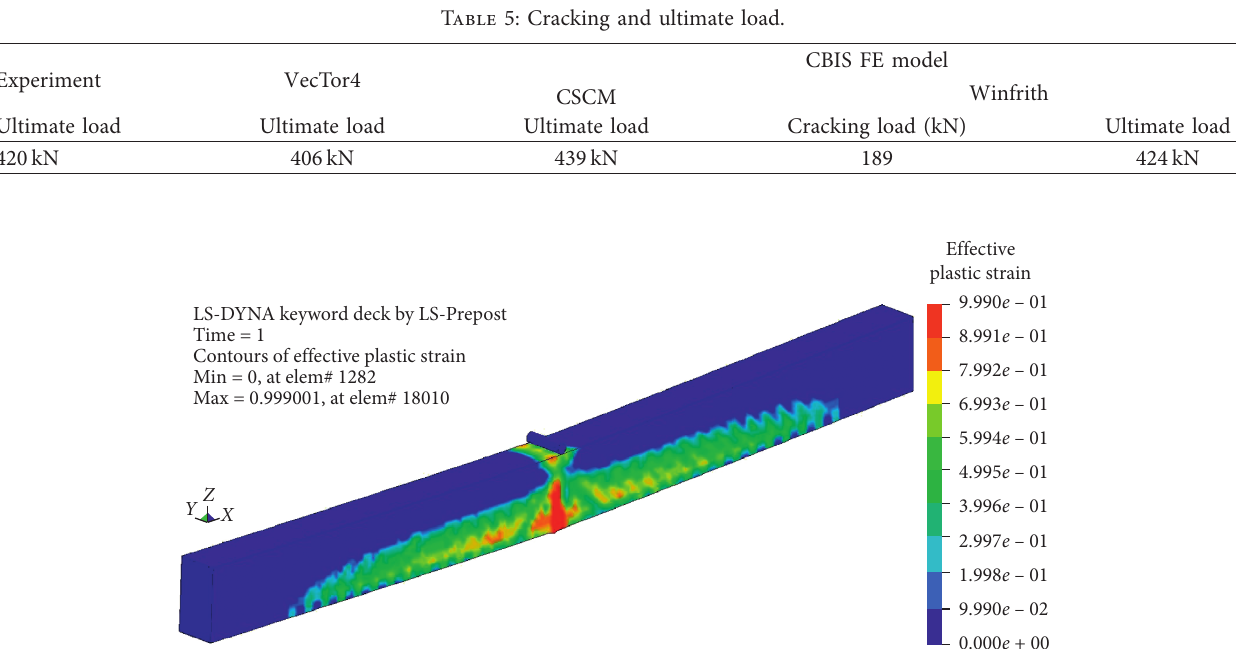
Figure 14: Distribution of effective plastic strain by CSCM concrete material option at the ultimate loading stage of P � 439kN.